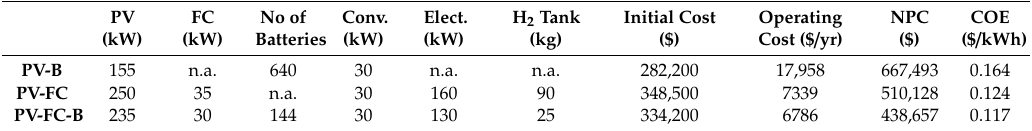
Table 3. Optimal size and related costs for each considered system.